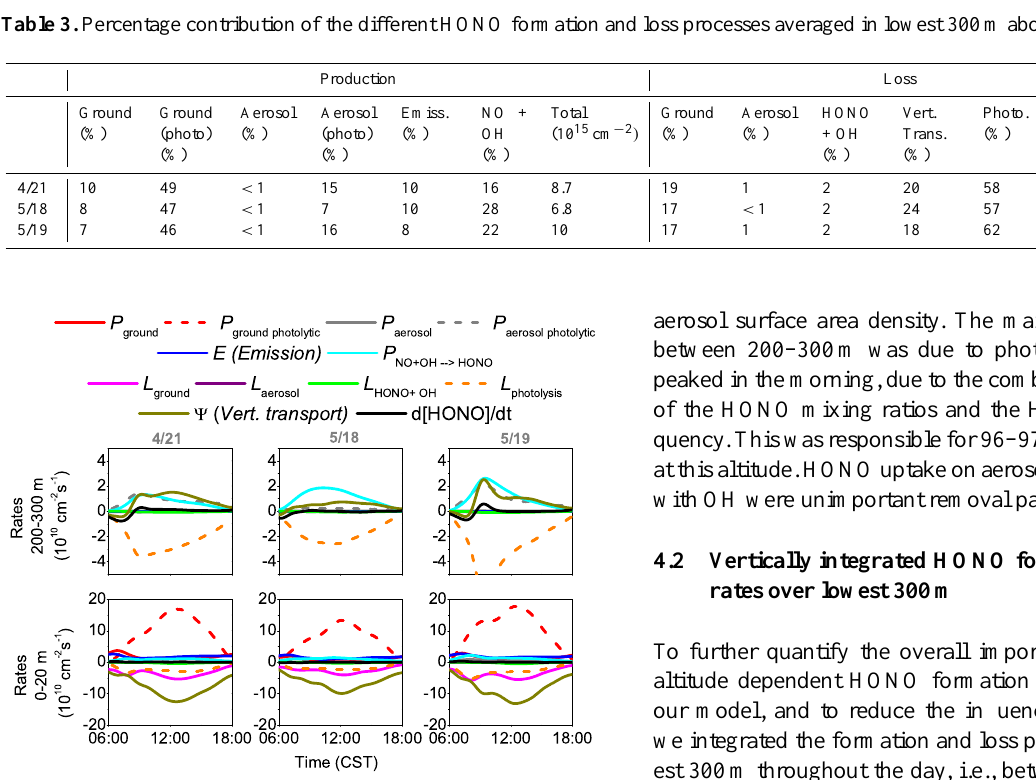
Fig. 10. Timeseries of the integrated HONO formation and loss rates in the lowest 20m (lower panels) and between 200–300m (upper panels) on 21 April, 18 May, and 19 May.